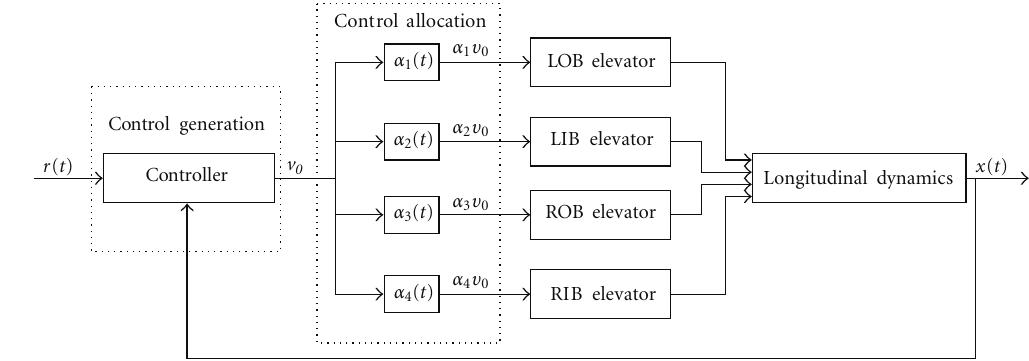
Figure 1: Aircraft pitch control with adaptive control